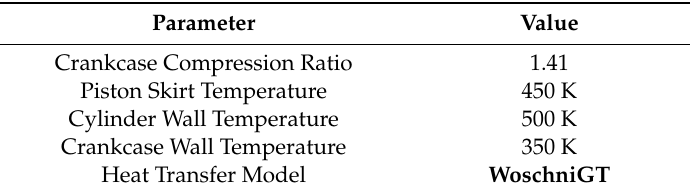
Table 8. Parameter settings of the simulation module of crankcase.